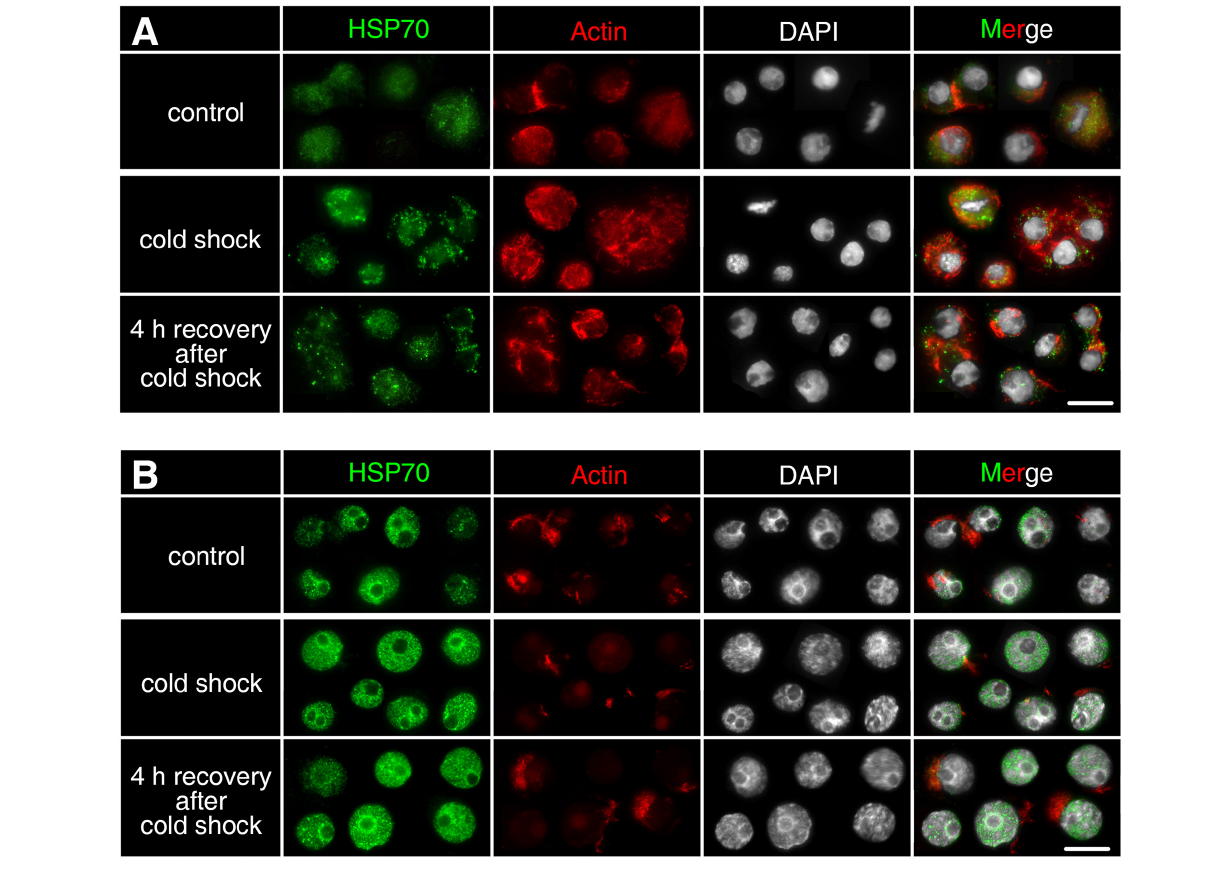
mechanism. With age, a severe reduction of the HSP70B protein level is observed in “d. V” diapausing embryos ( > 11